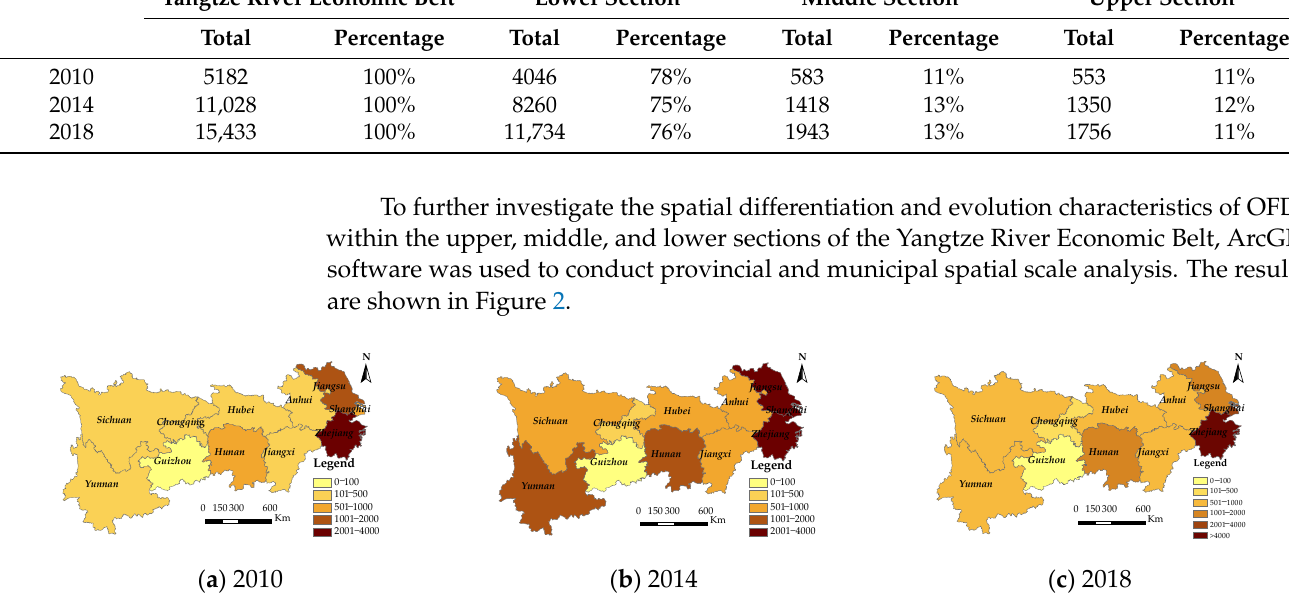
Table 2. Key indicators of the number of OFDI enterprises in the Yangtze River Economic Belt. Yangtze River Economic Belt Lower Section Middle Section Upper Section